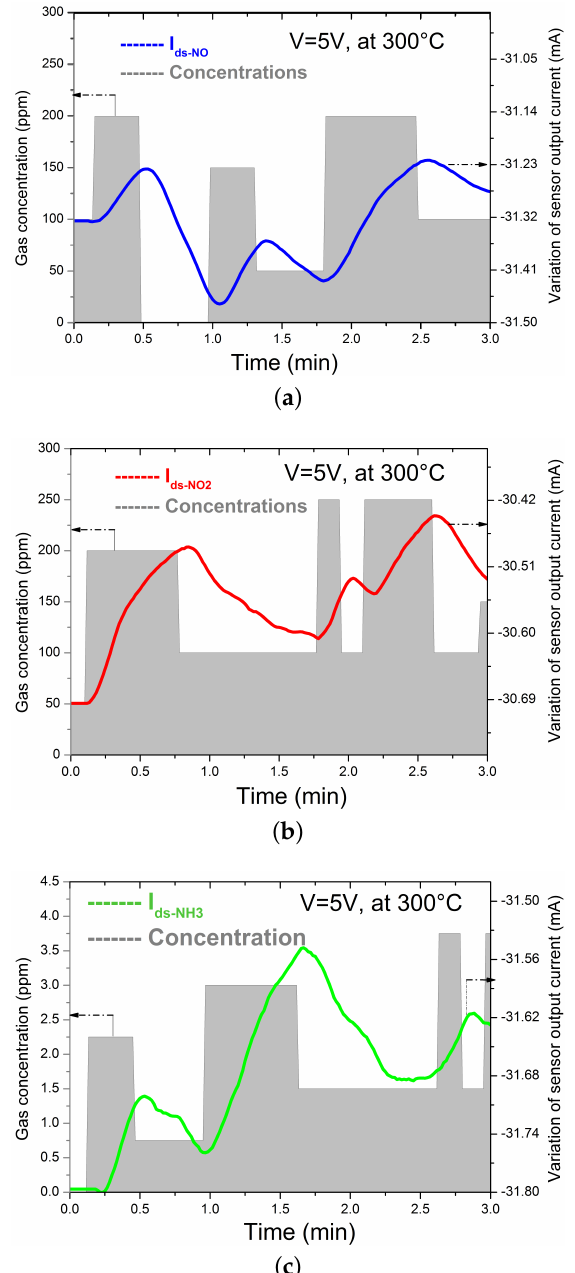
Figure 6. Dynamic response time of the Pt-AlGaN/GaN HEMT sensor to ( a ) NO; ( b ) NO 2 ; and ( c ) NH 3 as a function of